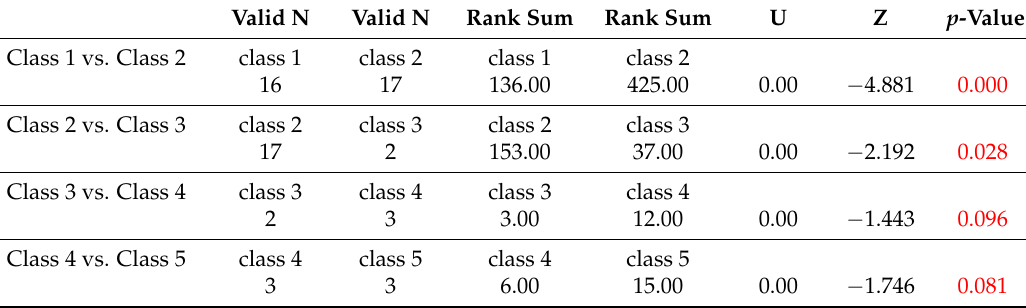
Table A1. Mann-Whitney U Test for TSS concentration Marked tests are significant at p <